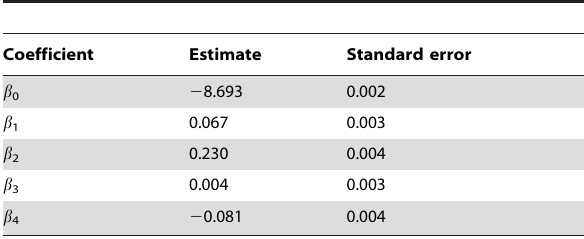
Table 1. Estimates and standard errors of the coefficients from the national general